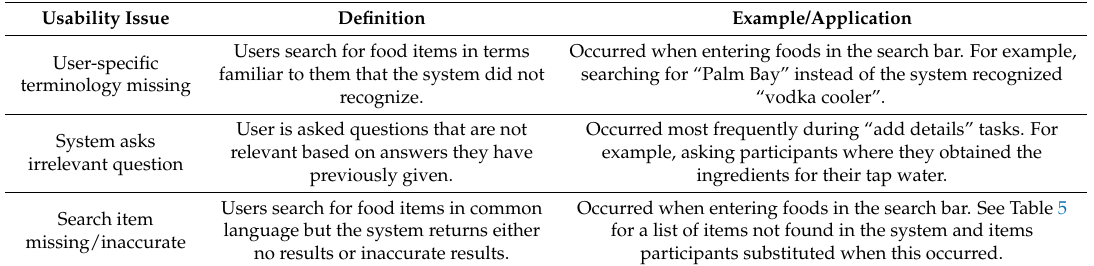
Table 4. Descriptions and examples of usability issues related to